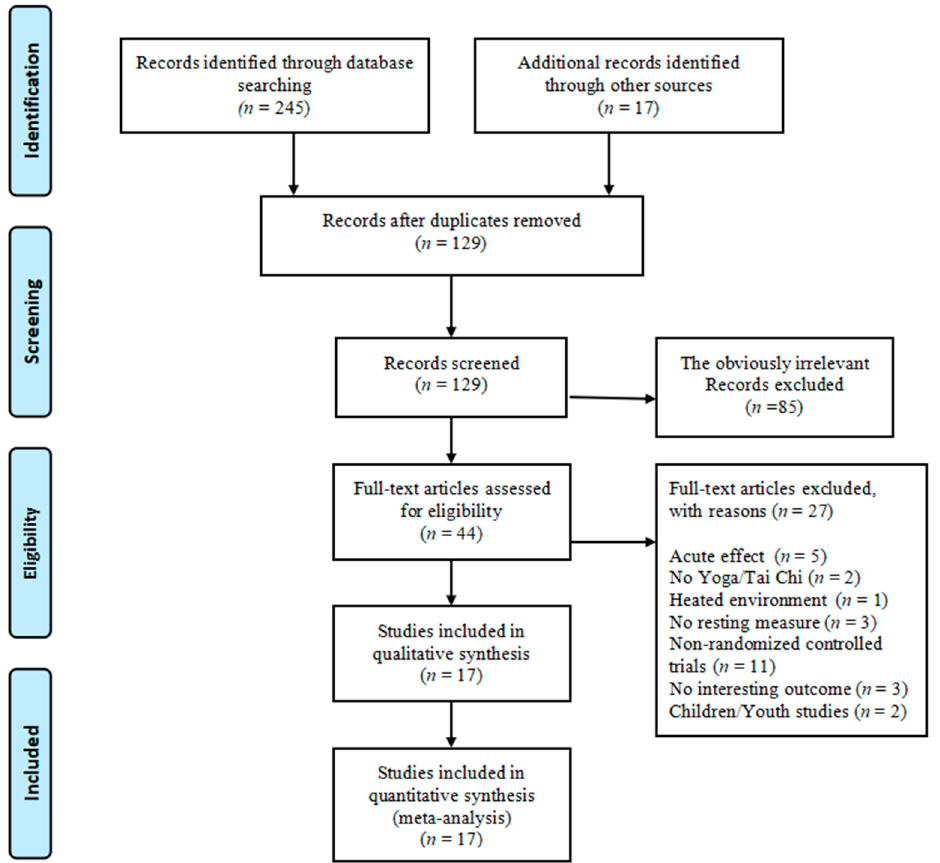
Figure 1. The process of selecting randomized controlled trials.